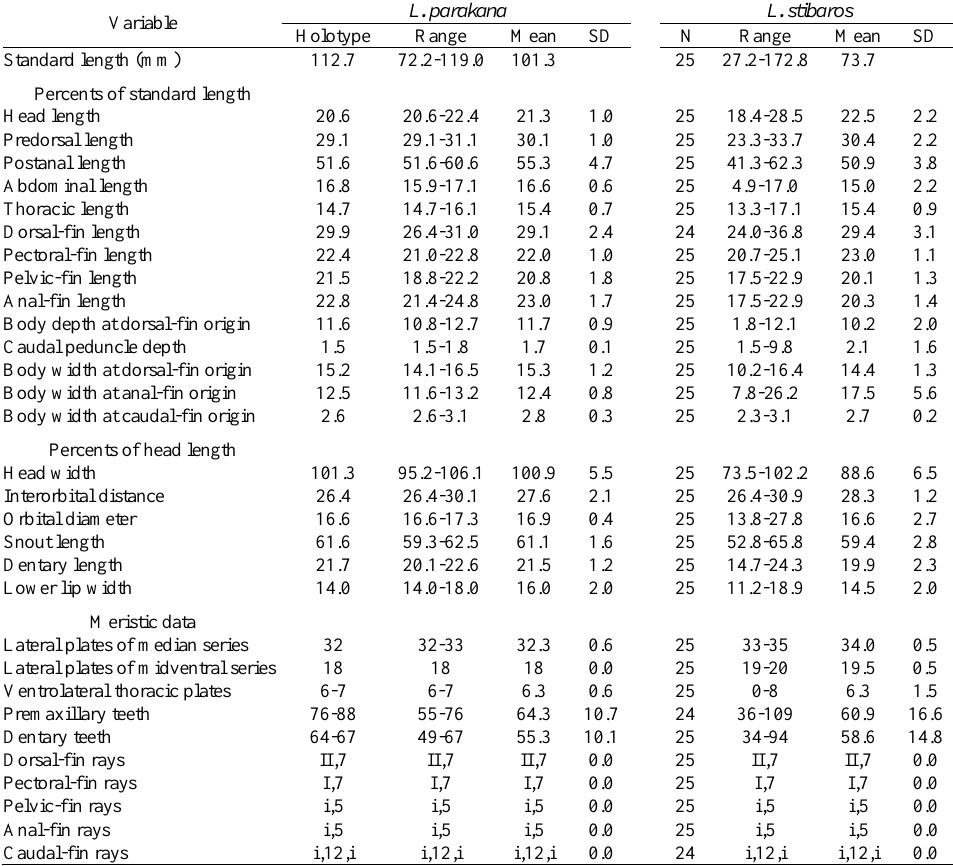
Table 3. Morphometric and meristic data for Lamontichthys parakana (n = 3) and L . stibaros . SD = standard deviation. Range of L . parakana includes holotype and